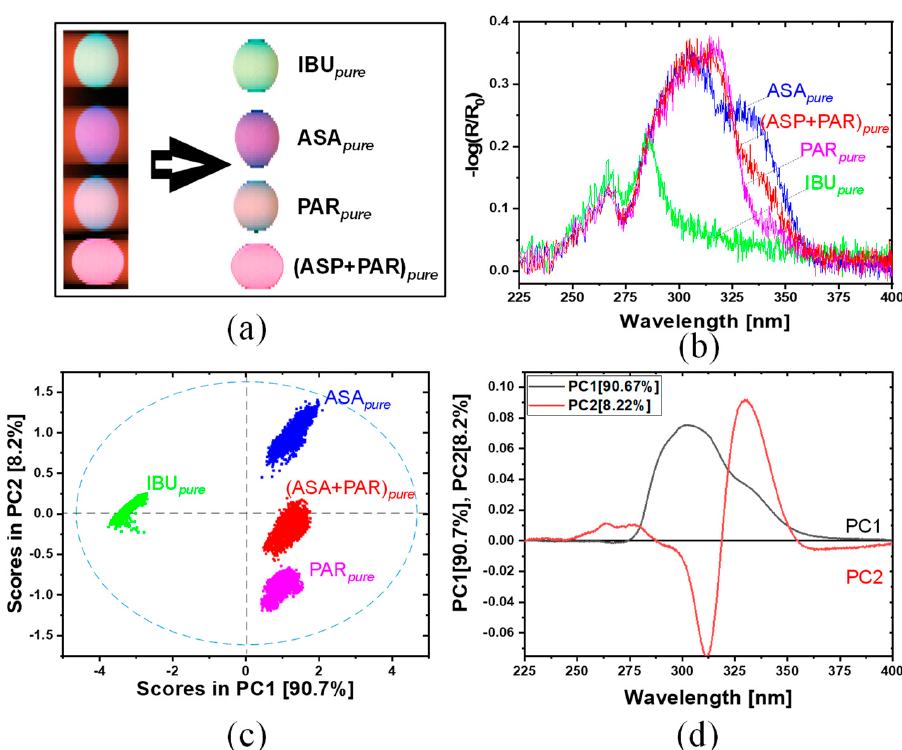
Figure 6. ( a ) Raw hyperspectral image for all API drug samples before and after subtracting the background. ( b ) Spectrum recorded for a single pixel of each of pure API samples in the UV range 225–400 nm. ( c , d ) Scores and corresponding loadings plot.